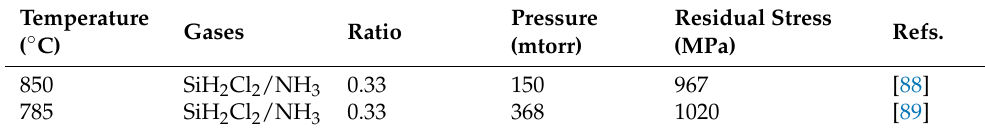
Table 4. Material Property Values of as-deposited LPCVD SiN thin-films layers.